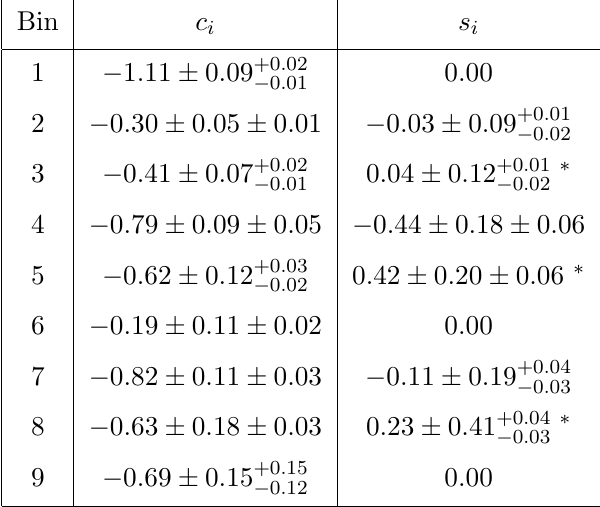
Table 9 . Final results for c i and s i values. The uncertainties are statistical and systematic, respectively. The s i results marked by * in bins 3, 5 and 8 are derived from those in other bins, according to the constraints of eqs.